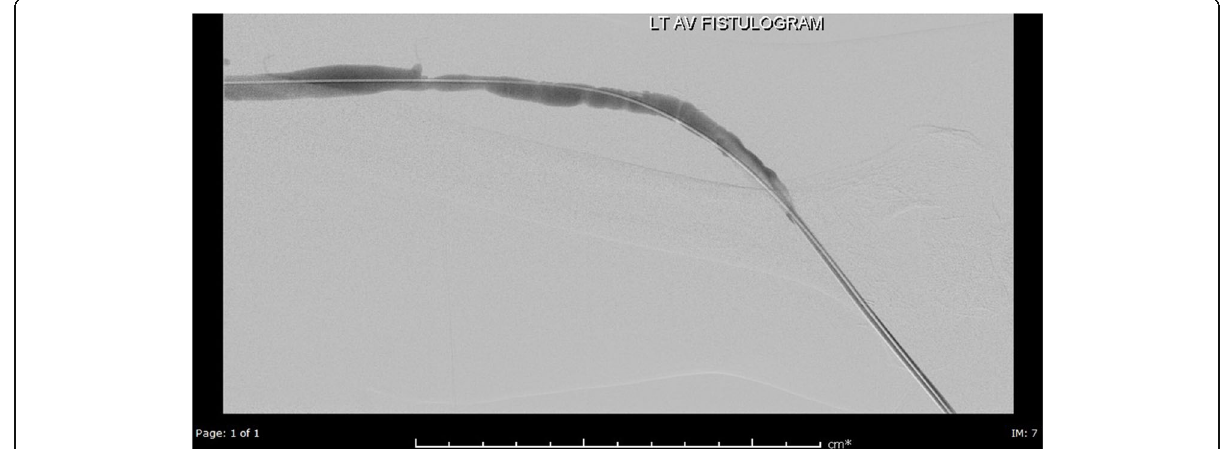
Fig. 1 Post plasty fistulogram demonstrating “ apparent recalcitrant ” stenosis which predominantly